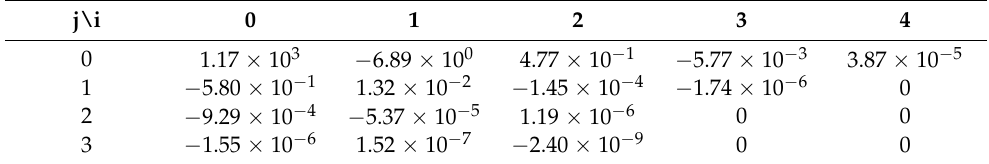
Table A4. Coefficients of the H 2 O-LiBr density